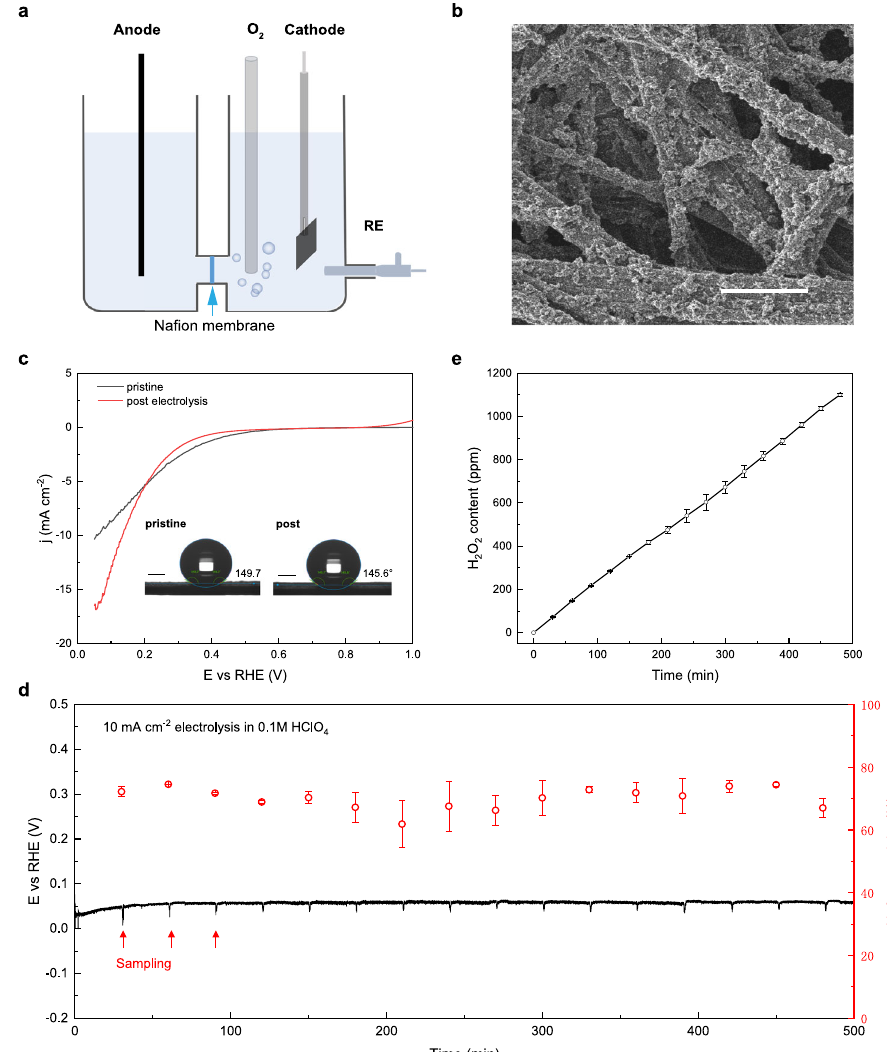
Fig. 4 Application of Pt-S-CNT catalyst in a H-cell electrolysis. a Schematic of a home-made H-type electrolyzer. b SEM image of Pt-S-CNT cast carbon fi ber paper as working electrode, scale bar: 500 nm. c LSV curves recorded on either pristine or post-electrolysis working electrode within 0.1 M O saturated HClO 4 at a scan rate of 5 mV s − 1 , inset shows the contact angles of a same working electrode prior to and post 500-min electrolysis at the scale bar of 1 mm. d The ORR stability test of working electrode potential and H 2 O 2 selectivity under a fi xed current density of 10 mA cm − 2 for 500 min continuous electrolysis. e The accumulated H 2 O 2 concentration during the stability measurement. The error bars represent two independent